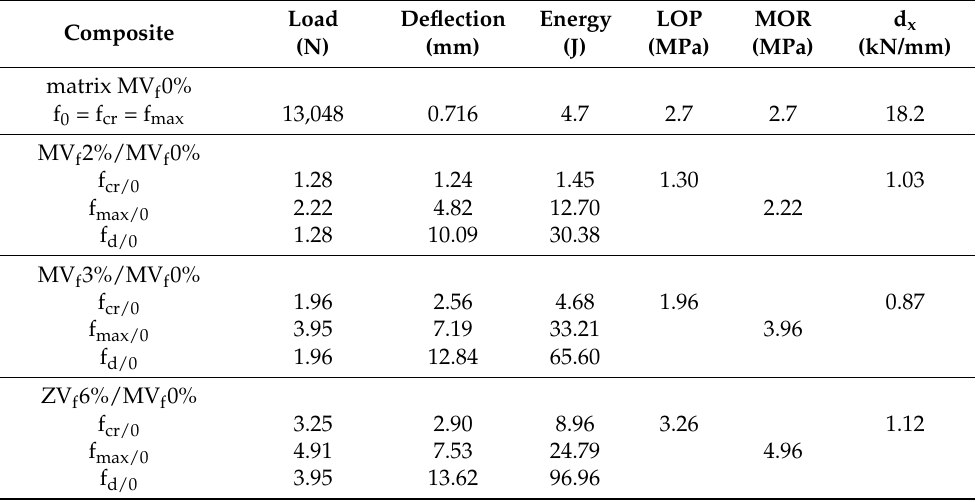
Table 3. The tested specimens, a compilation of the obtained results as compared with a reference